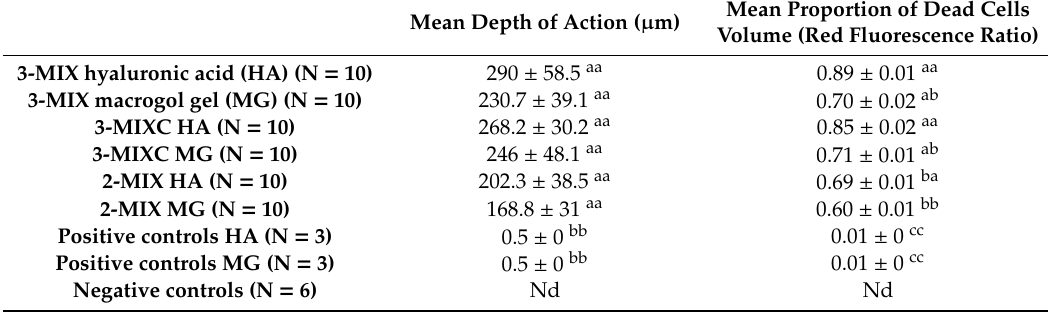
Superscript letters: the di ff erent letters show the statistically significant di ff erences among the groups ( p < 0.05). The first superscript letter refers to the comparison between the antibiotic pastes, while the second one refers to the type of vehicle tested. Nd: data not